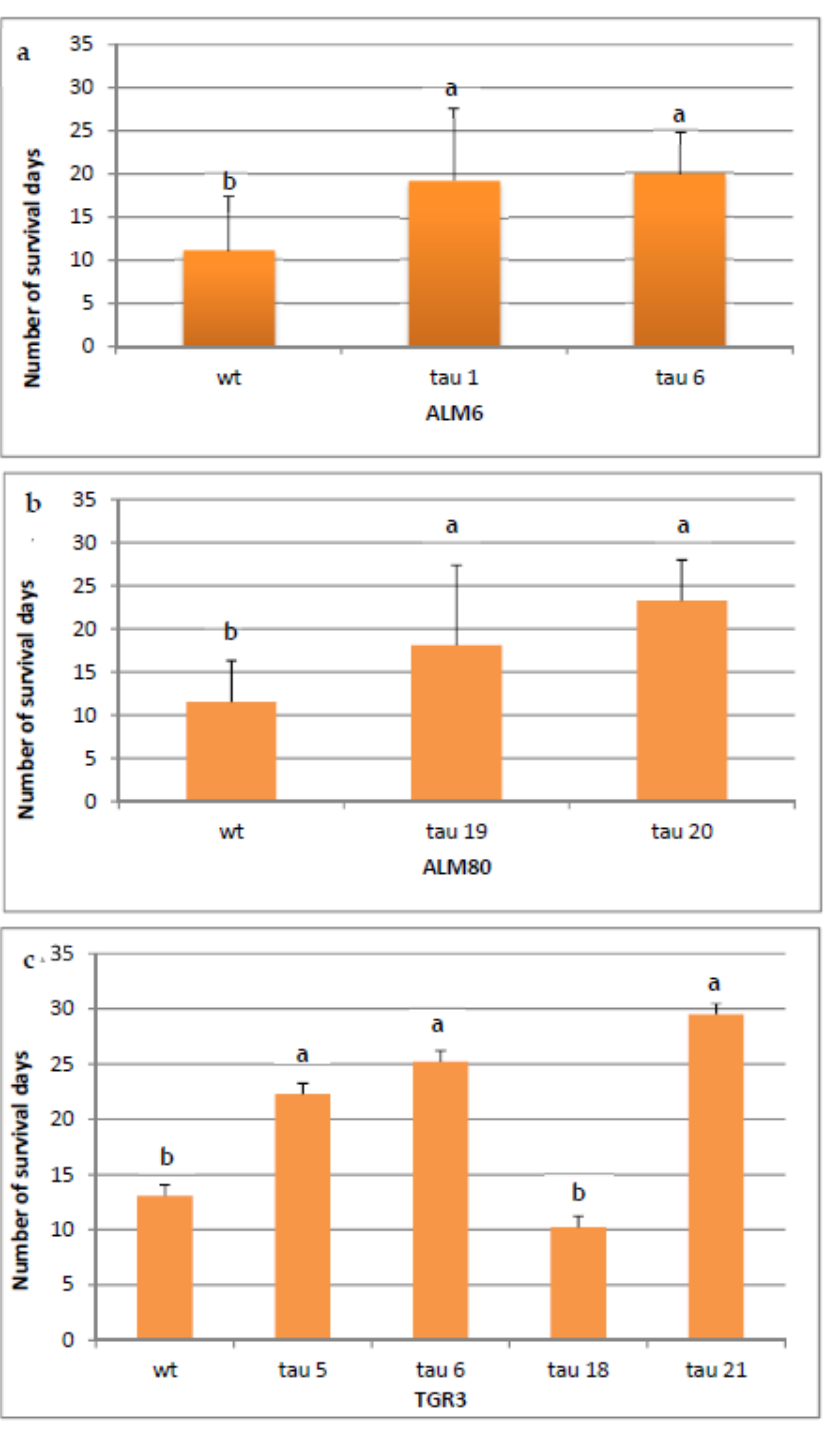
Figure 7. Survival rate of transgenic and non-transgenic (wt) cork oak lines derived from genotypes ALM6 ( a ), ALM80 ( b ) and TGR3 ( c ) 31 days after infection with P. cinnamomi . A total of 18 plantlets were evaluated for each transgenic and wt line. Vertical lines indicate the standard errors of mean values. Data were analyzed by ANOVA I ( p ≤ 0.05). Values in columns indicated with the same letter are not significantly different ( p = 0.05, Duncan’s test).